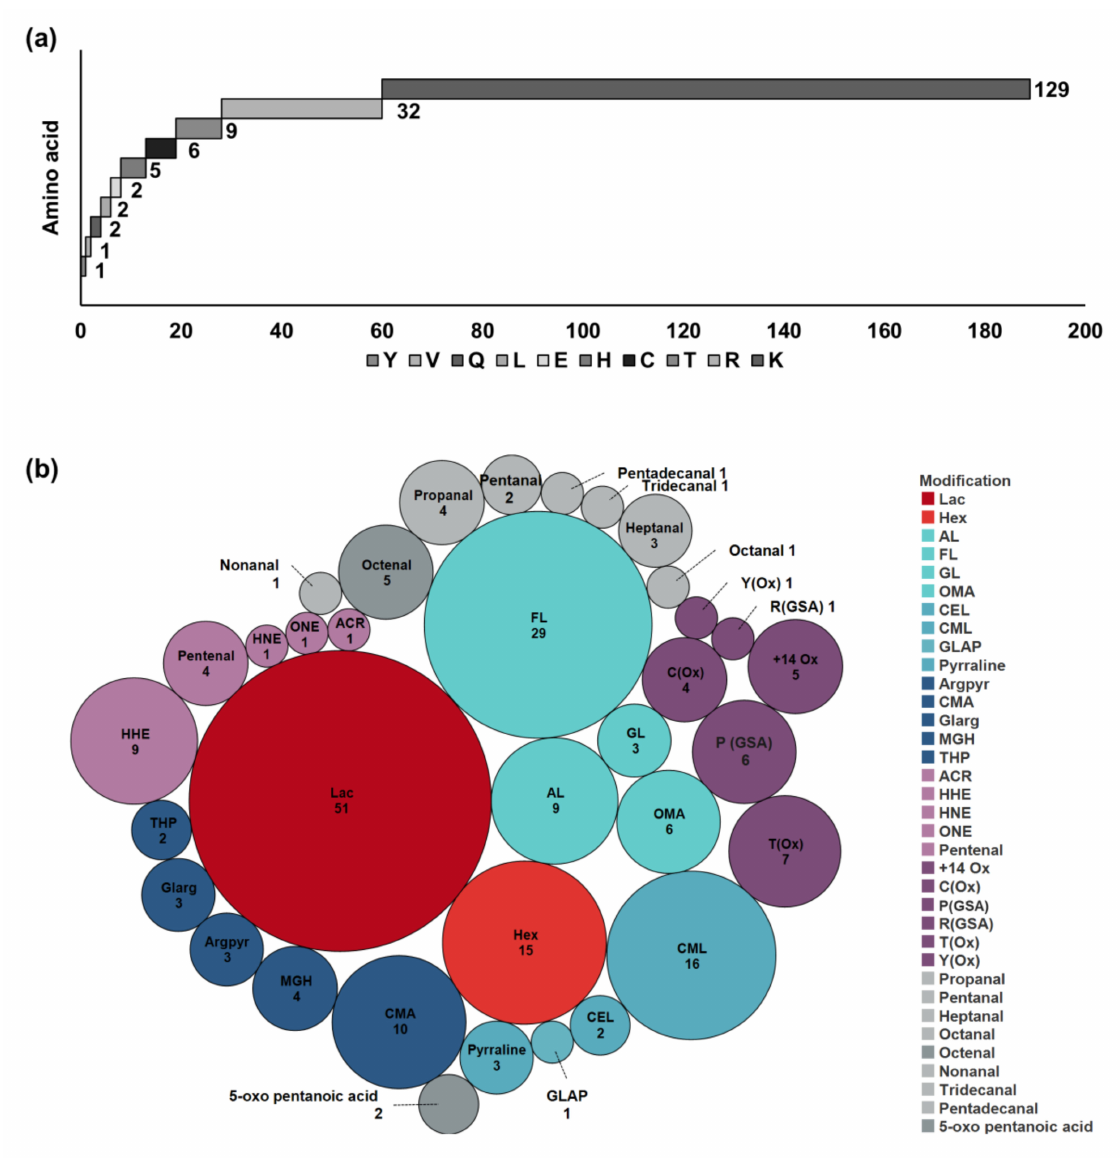
Figure 2. ( a ) Number of unique modified amino acid residues and ( b ) peptides carrying Amadori (red), advanced glycation end product (AGE) (blue), carbonylation / oxidation (purple), and low molecular weight (LMW) carbonyl (grey) modifications. Doubly-modified peptides were counted once for each modification. The following modifications were identified: hexosylation (Hex), lactosylation (Lac), acetyllysine (AL), formyllysine (FL), glycerinyllysine (GL), oxalic acid monolysinylamide (OMA),carboxyethyllysine(CEL),carboxymethylationofLys / Arg(CML / CMA),glyceraldehyde-derived pyridinium (GLAP), pyrraline, argpyrimidine (Argpyr), glyoxal-derived hydroimidazolium (Glarg), methylglyoxal-derived hydroimidazolones (MGH), tetrahydropyrimidine (THP), acrolein (ACR), 4-hydroxy-2-hexenal (HHE), 4-hydroxy-2-nonenal (HNE), 4-oxo-2-nonenal (ONE), pentenal, + 14 carbonylation ( + 14 Ox) [31], oxidation (Ox), glutamic-semialdehyde (GSA), propanal, pentanal, heptanal, octanal, nonanal, tridecanal, tetradecanal, pentadecanal, octenal, and 5-oxo pentanoic acid. Thirty-six carbonylated / oxidized peptides from 26 proteins were identified (Table S2), i.e., nine HHE-derived peptides (6 × Lys, 2 × His, and 1 × Cys), seven peptides with oxidized threonine